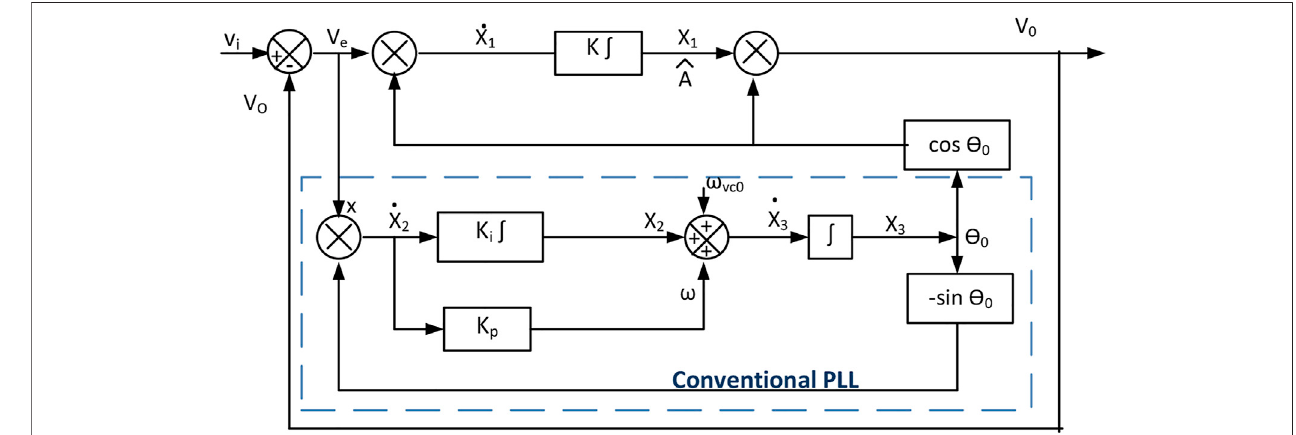
FIGURE 3 | Basic scheme of a single-phase EPLL.